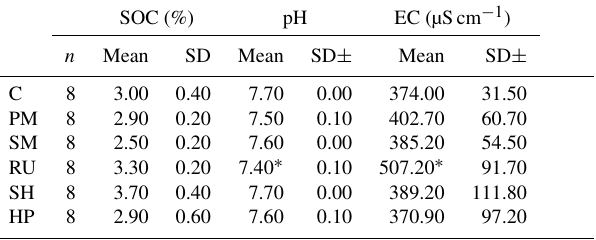
Table 2. Soil organic carbon (SOC), soil acidity (pH), and soil salinity (EC) (mean and standard deviation (SD), n = 8) measured 30 months after the plots’ afforestation. C: soil afforested and not amended; PM: mulch with chipped branches of Aleppo pine ( Pinus halepensis L.) ; SM: straw mulch; RU: sewage sludge; SH: sheep manure compost; HP: TerraCottem hydroabsorbent polymers. The ∗ symbol indicates a significant difference compared to the control (C) ( P